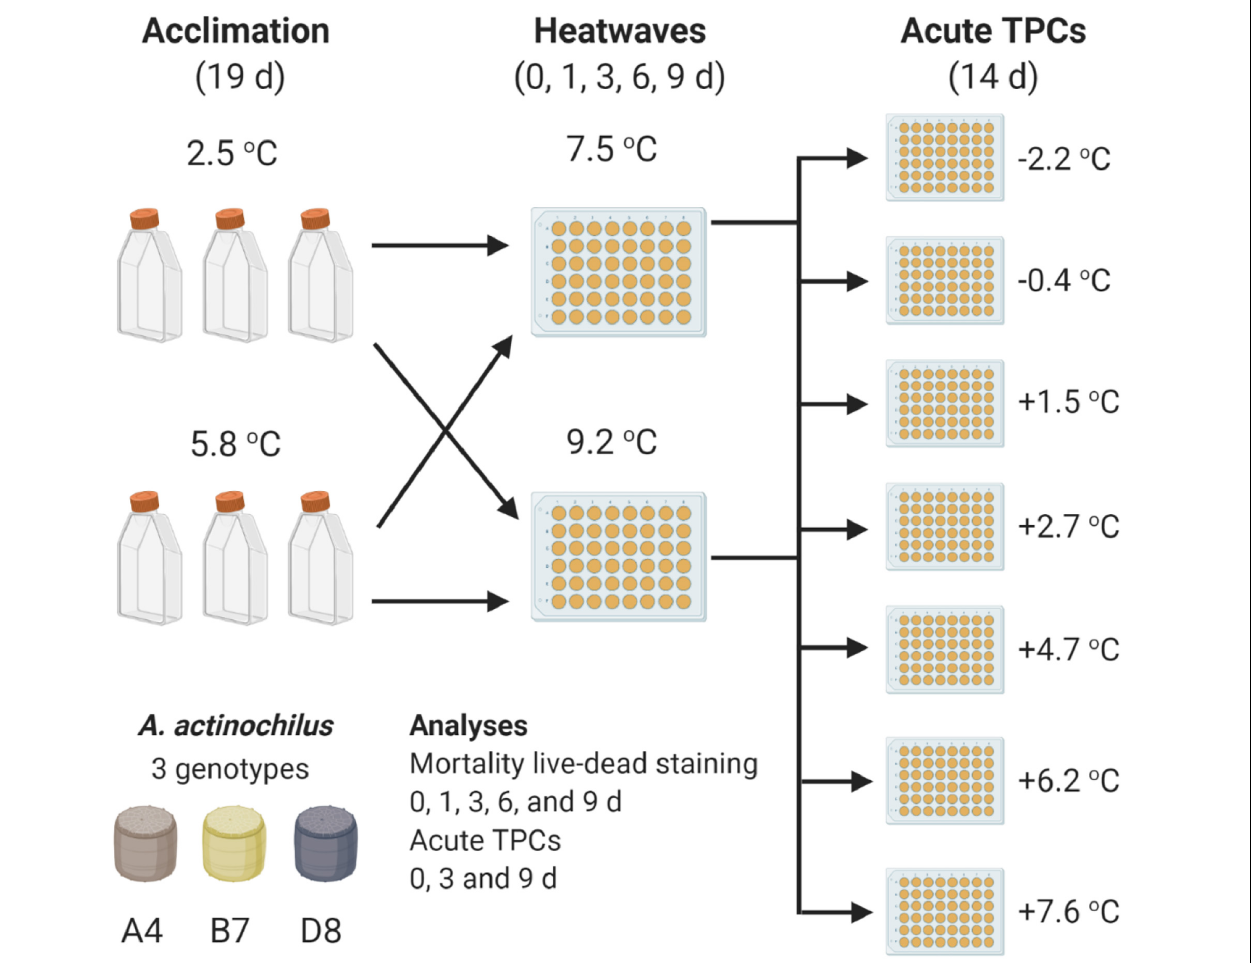
FIGURE 1 | Overview of experimental design for the heatwave treatment. All temperatures shown are absolute temperatures for incubation. A near-identical design was used for the control treatment, in which cultures grown at 2.5 and 5.8 ◦ C in the first (acclimation) phase are maintained near these temperatures (2.7 and 6.2 ◦ C) in the second (heatwave) phase ( Supplementary Figure 1